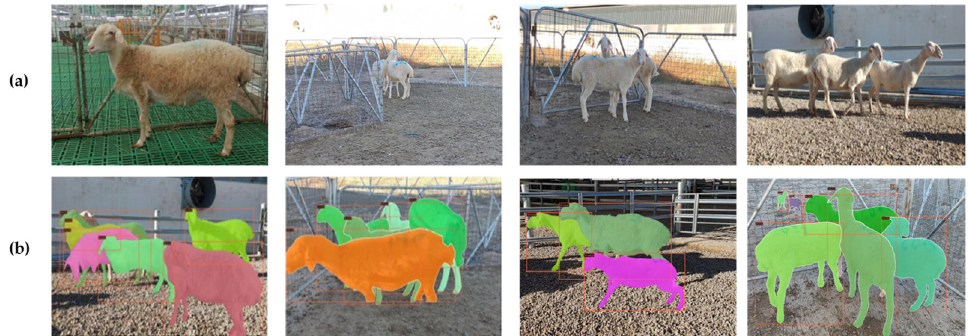
Figure 1. Examples of sheep images. ( a ) represents the images collected from di ff erent area, light, perspectives, and distances. ( b ) represents the training data after data augmentation.